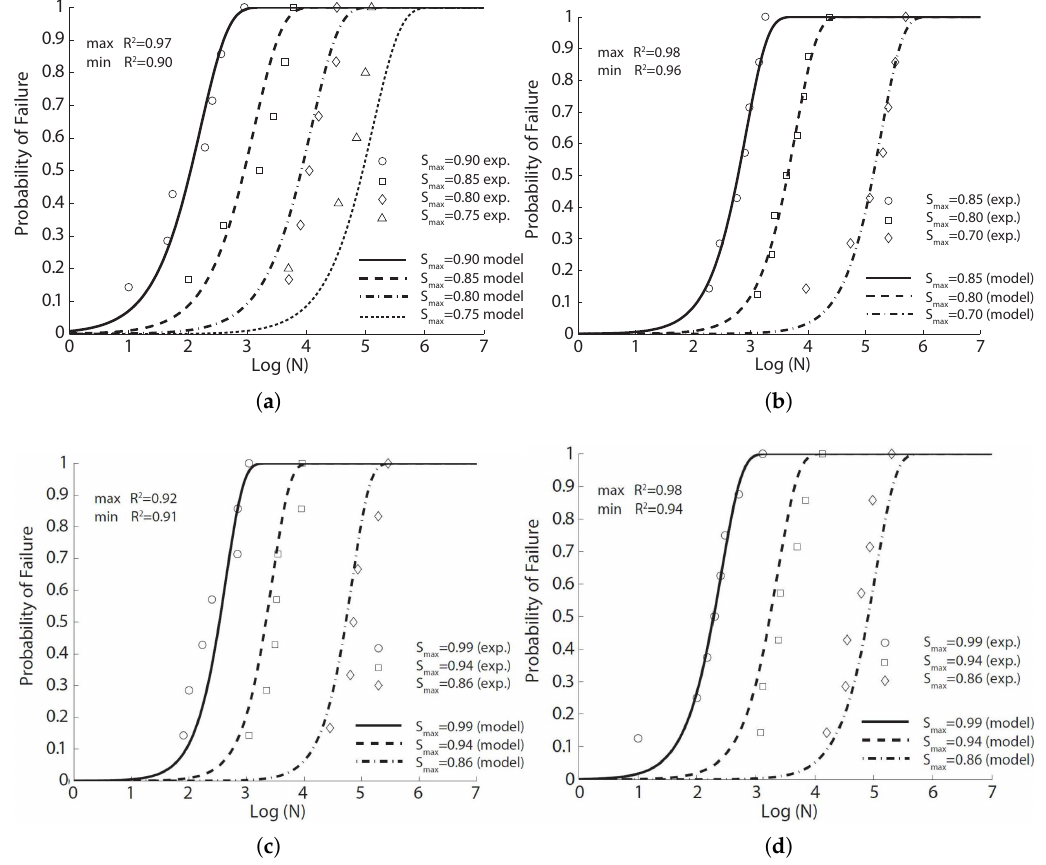
Figure 2. Comparison of flexural fatigue data of Johnston and Zemp [41] with the fitted probabilistic model Equation (8) for concrete reinforced with smooth hard-drawn fibers, aspect ratio of 75: ( a ) 0%; ( b ) 0.5%; ( c ) 1% and ( d ) 1.5% volume ratios.